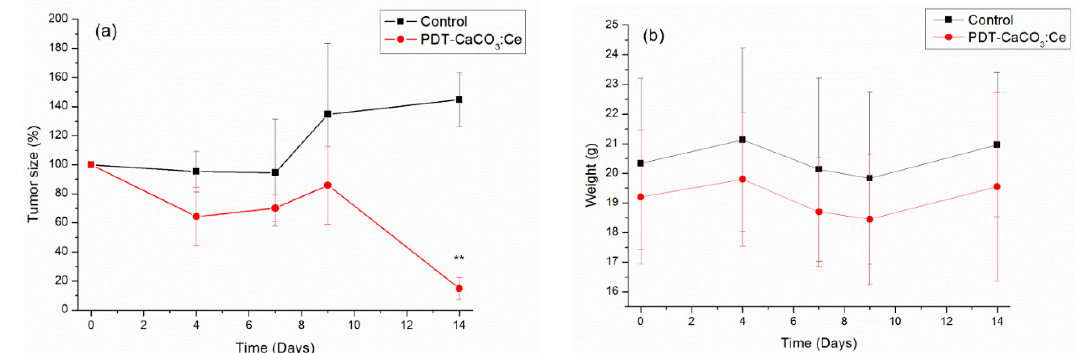
Figure 8. The tumor size ( a ) and body weight ( b ) in BALB/c nude mice injected with CaCO 3 :Ce and subjected to X-ray irradiation ( t -test, mean ± SD, n = 4, **: p -value < 0.01).